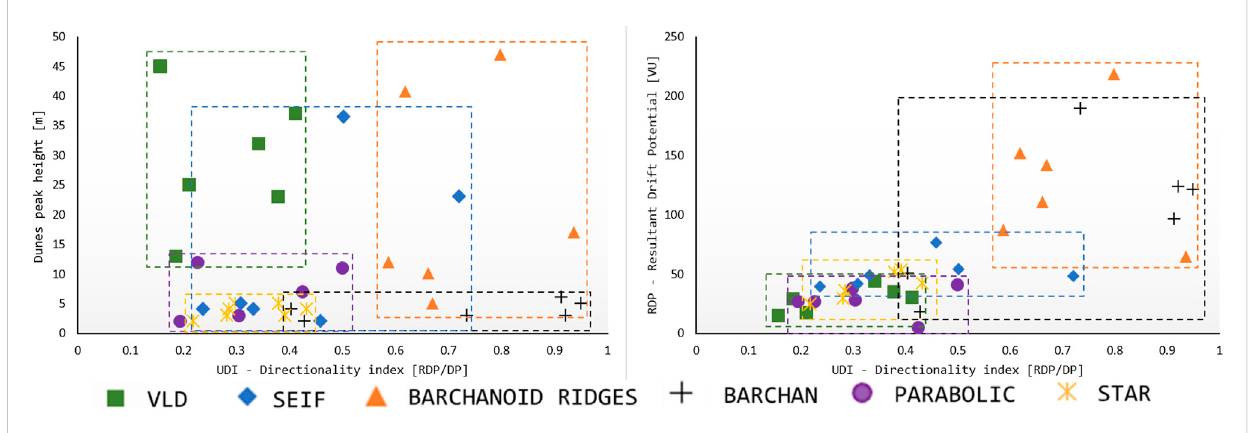
FIGURE 12 Examined average of vegetated linear dunes (VLDs), seif, barchan, barchanoid, star, and parabolic dunes heights and overlapping resultant drift potential (RDPs) aligned to the calculated wind directionality index (UDI)